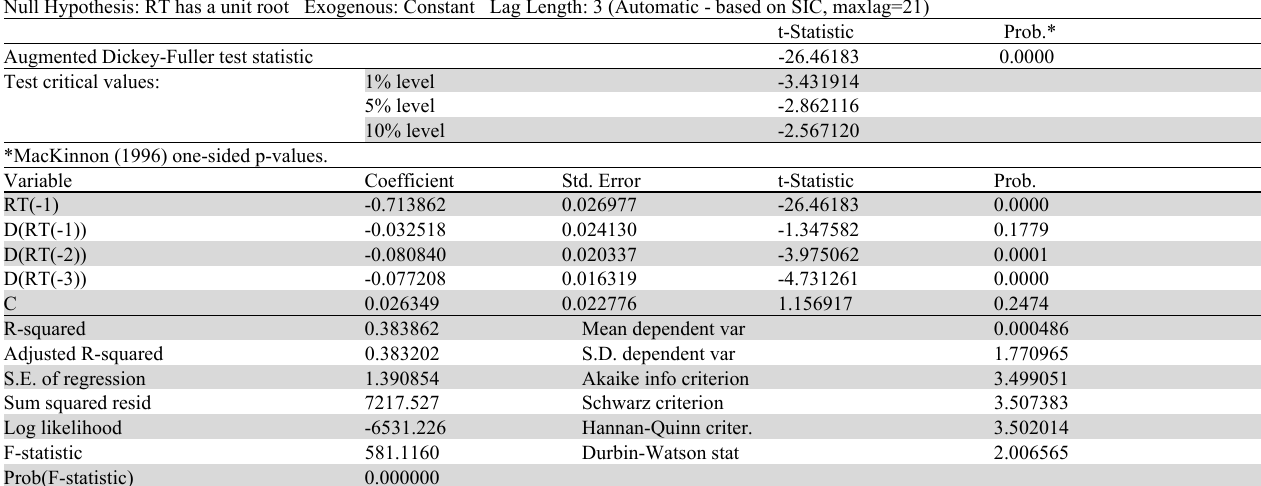
Unit Root test results for the Index series